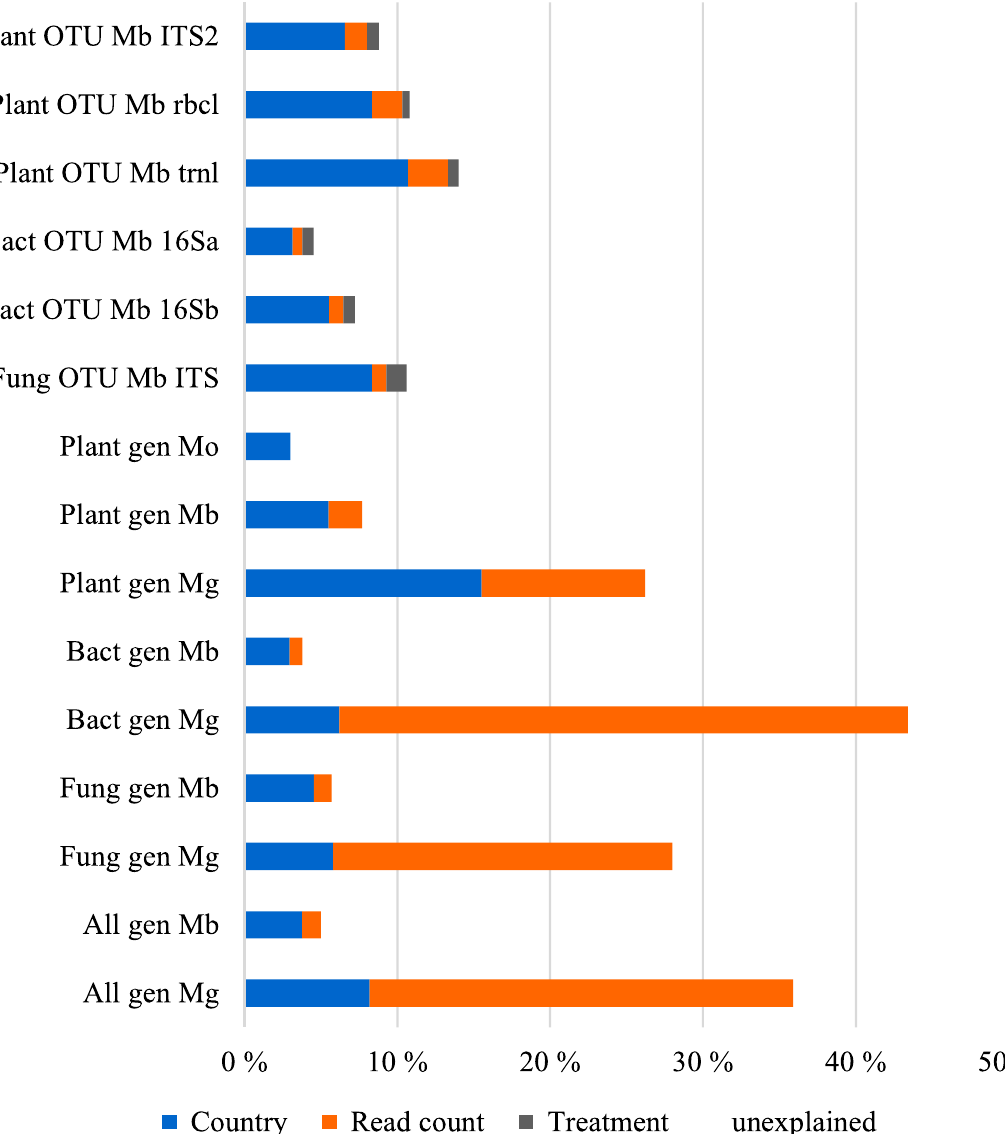
Figure 4. Variation explained by the joint species distribution models fitted to each of the data sets. The total amount of variance explained is quantified by Tjur R 2 , which is shown as the length of the bars. The colors indicate the proportion of variance explained by each of the variables included in the models: country, read count and treatment (filtering, applied only to part of the datasets). The taxonomic groups are plants (Plant), bacteria, (Bact), fungi (Fung) and all (All), the taxonomic levels are OTUs (OTU) and genera, and the methods metabarcoding (Mb), metagenomics (Mg) and morphological identification of pollen (Mo). For metabarcoding the different gene regions are examined at the OTU level separately, and the gene regions are given at the end of the dataset